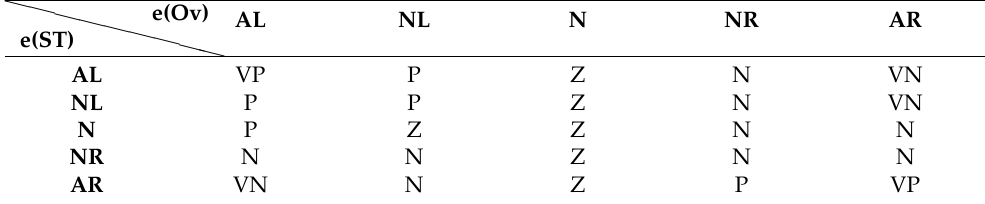
Table 1. Fuzzy rule matrix for variables a (cid:48) and c (cid:48) .